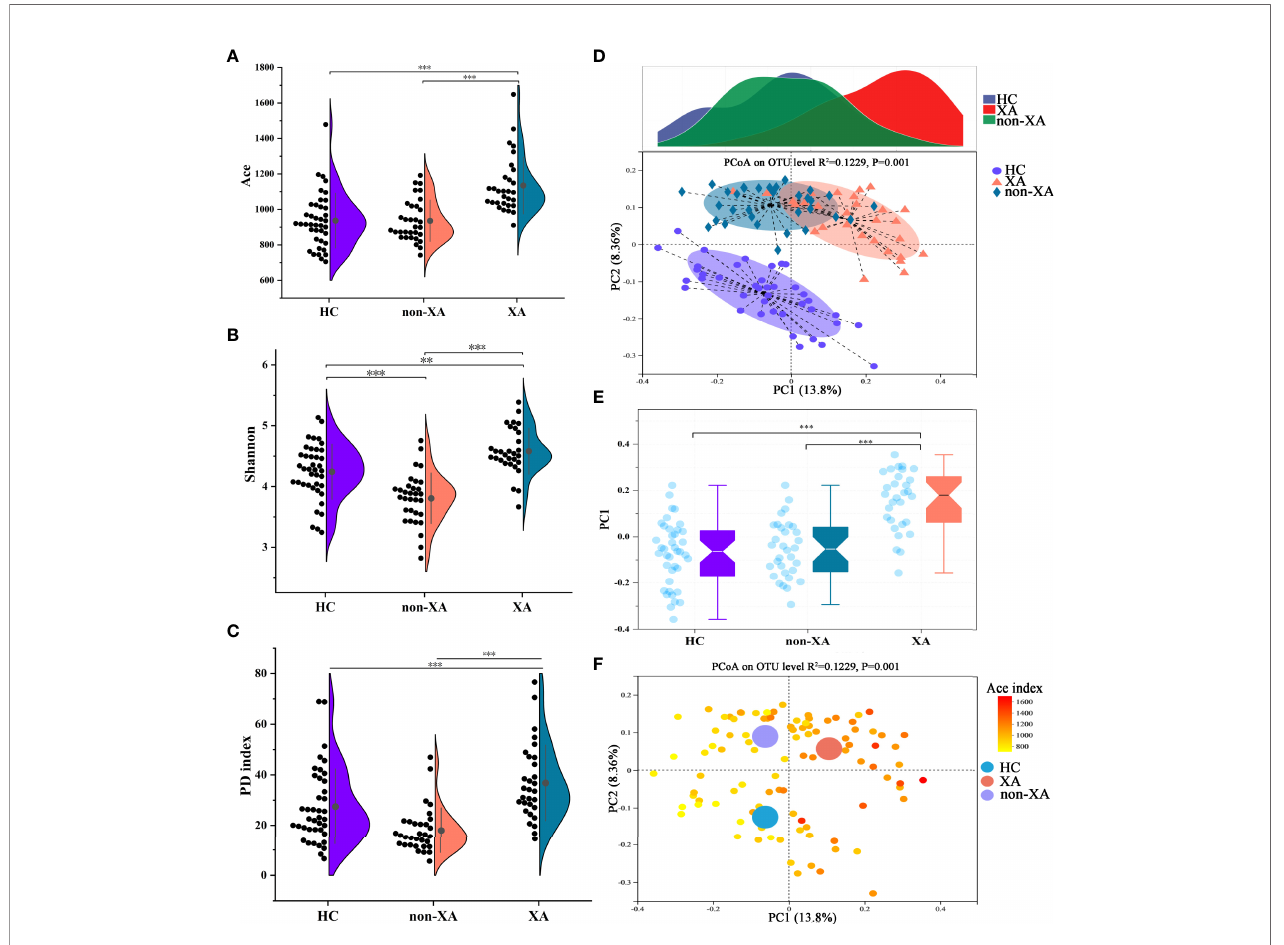
FIGURE 1 | Oral microbial characterization among XAs, non-XAs, and HCs. The a diversity index of Ace (A) , Shannon (B) , and PD index (C) in XAs was signi fi cantly increased compared to non-XAs and HCs. (D, E) The principal coordinate analysis (PCoA) revealed that the b -diversity for the oral microbiota of XAs was also clearly separated from non-XAs and HCs. (F) PCoA as in (D) , colored according to Ace index. XAs, xerostomia patients; non-XAs, patients without xerostomia; HCs, healthy controls; PD, phylogenetic diversity, OTUs, operational taxonomic